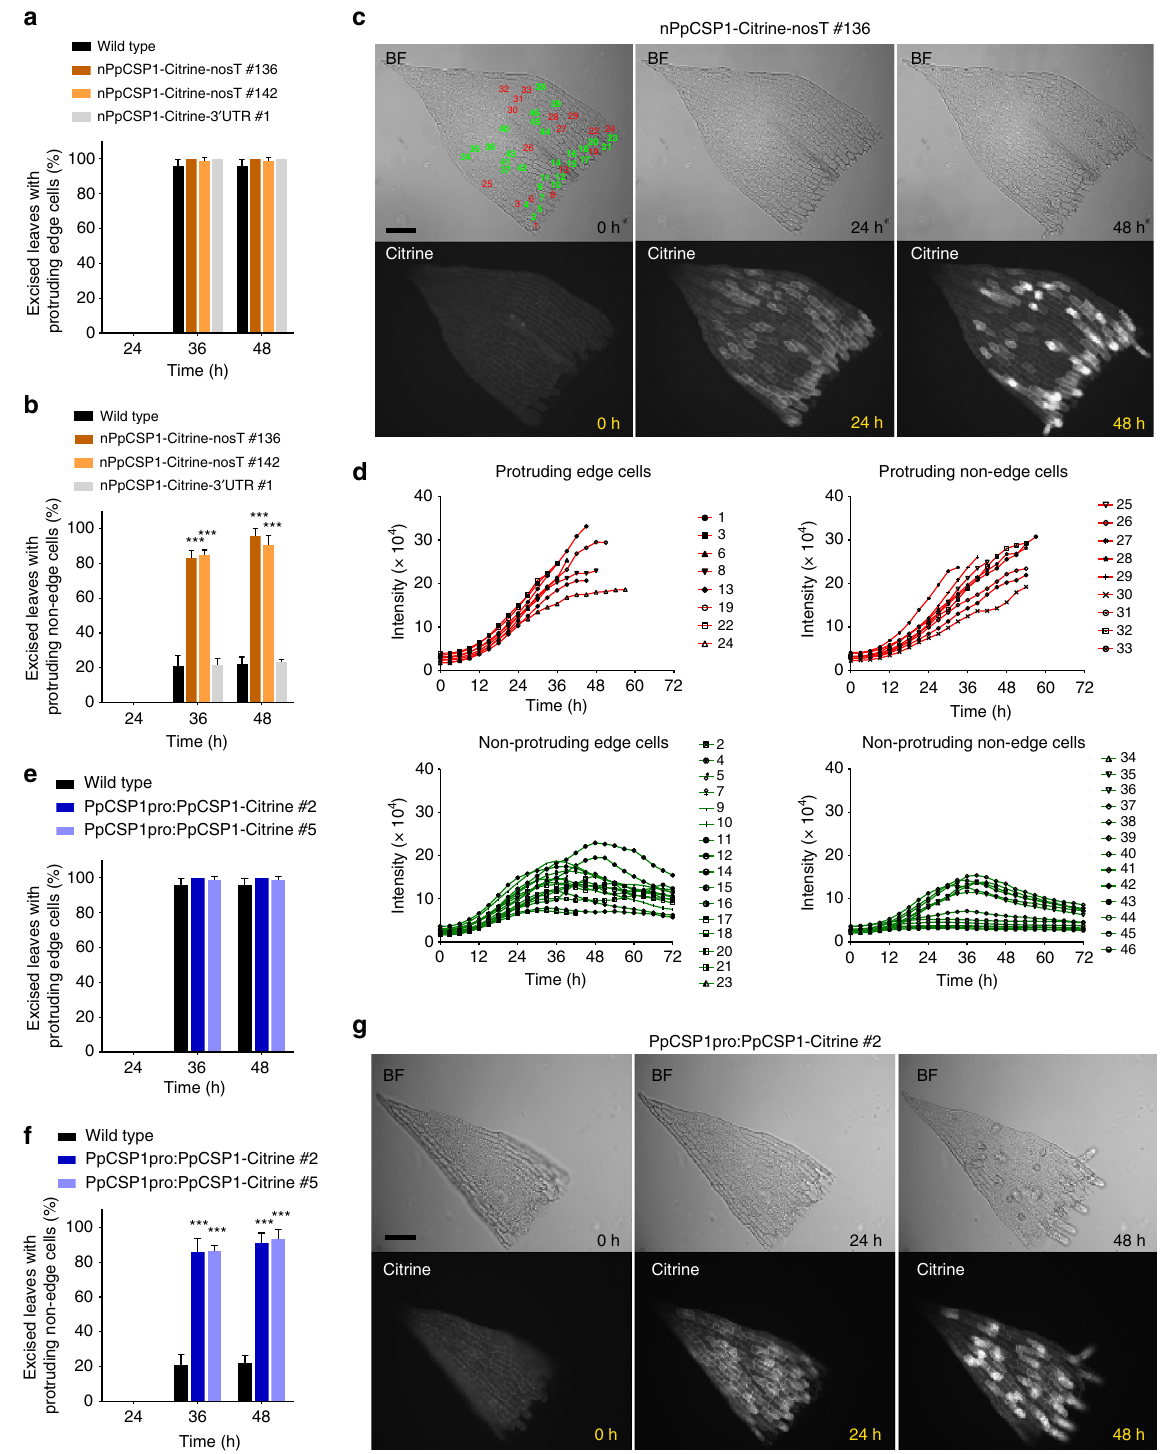
Figure 4 | Increased PpCSP1 protein accumulation causes enhanced reprogramming. ( a , b ) Percentages of excised leaves with protruding edge cells ( a ) and protruding non-edge cells ( b ). Twenty leaves excised from wild type, nPpCSP1-Citrine-nosT (#136 and #142), and nPpCSP1-Citrine-3 0 -UTR #1 were used for each analysis. Error bars represent s.d. from biological triplicates. *** P o 0.001 by two-sided Welch’s t -test. ( c ) Expression pattern of PpCSP1-Citrine in an excised leaf of nPpCSP1-Citrine-nosT #136. Bright-field (BF) and Citrine images at 0, 24 and 48h after cutting are shown. All edge cells and several non-edge cells are numbered for d . See also Supplementary Movie 5. ( d ) The intensity of Citrine signals in each cell (numbers correspond to cells in the top panel of c ) of an excised leaf of nPpCSP1-Citrine-nosT #136. Red and green lines indicate the intensities of Citrine signals in protruding and non-protruding cells, respectively. ( e , f ) Percentage of excised leaves with protruding edge cells ( e ) and protruding non-edge cells ( f ). Twenty leaves were excised from wild type and PpCSP1pro:PpCSP1-Citrine (#2 and #5). Error bars represent the s.d. from biological triplicates. *** P o 0.001 by two-sided Welch’s t -test. ( g ) Expression patterns of PpCSP1-Citrine in an excised leaf of PpCSP1pro:PpCSP1-Citrine #2. BF and Citrine images at 0, 24 and 48h after cutting are shown. Scale bars, 100 m m ( c , g